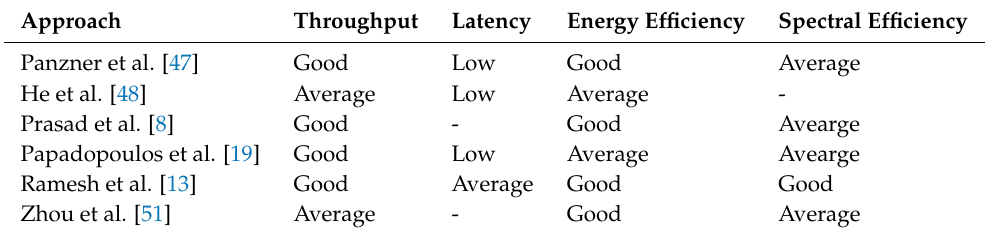
Table 5. Summary of massive MIMO-based approaches in 5G technology.